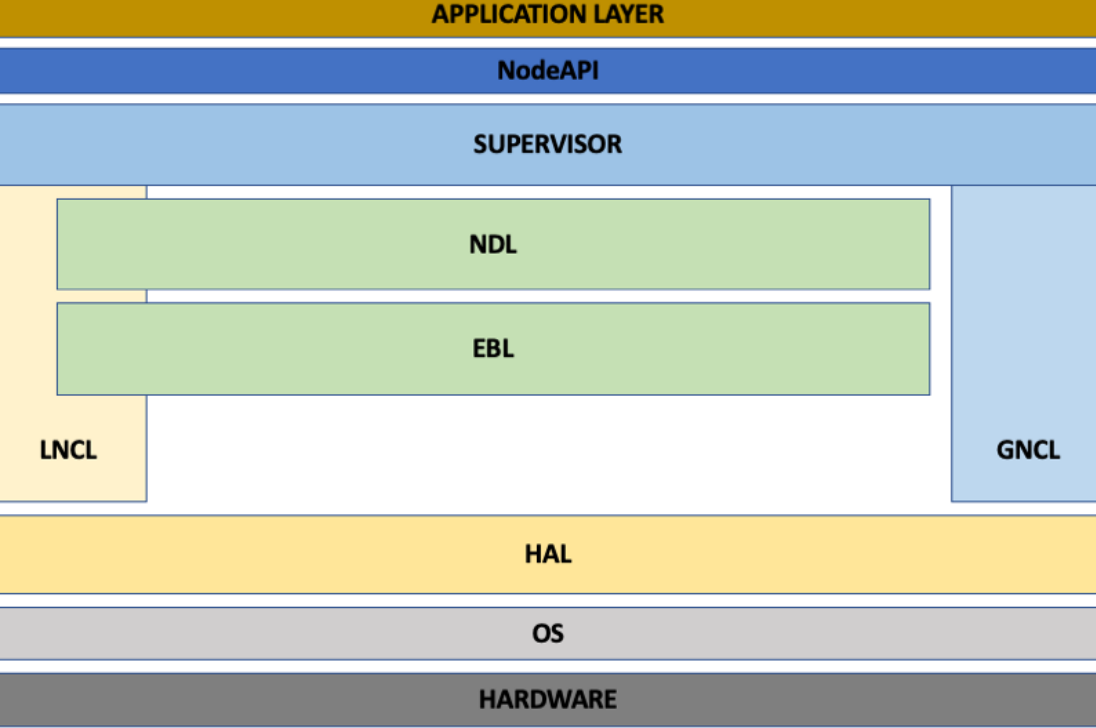
Figure 1. Schemes follow the same formatting.